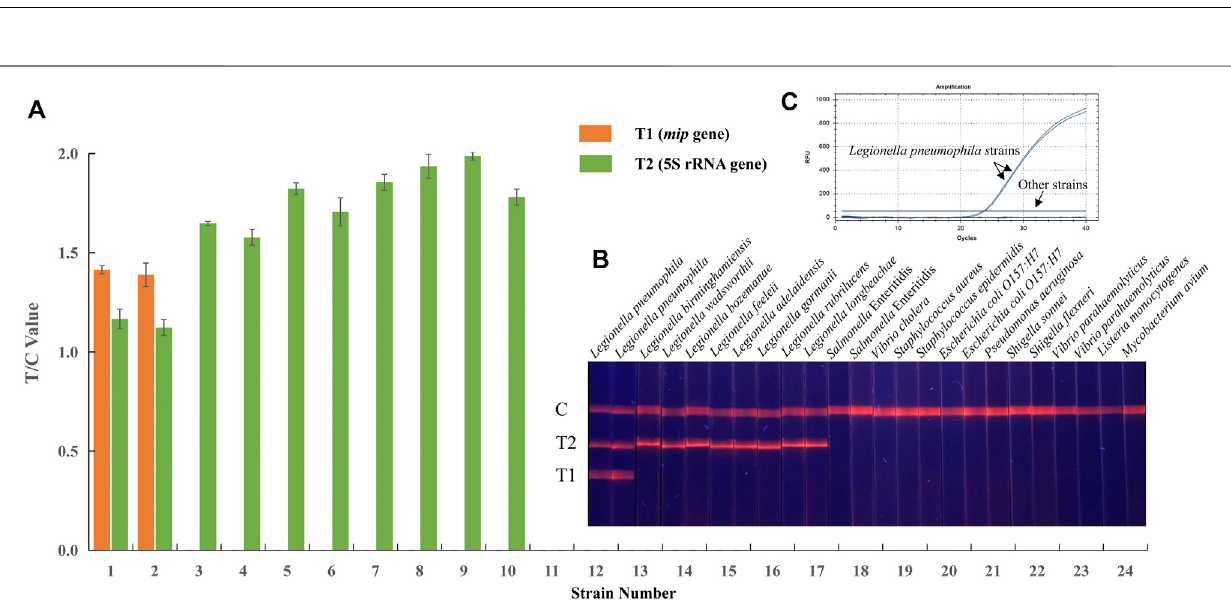
Frontiers in Chemistry |